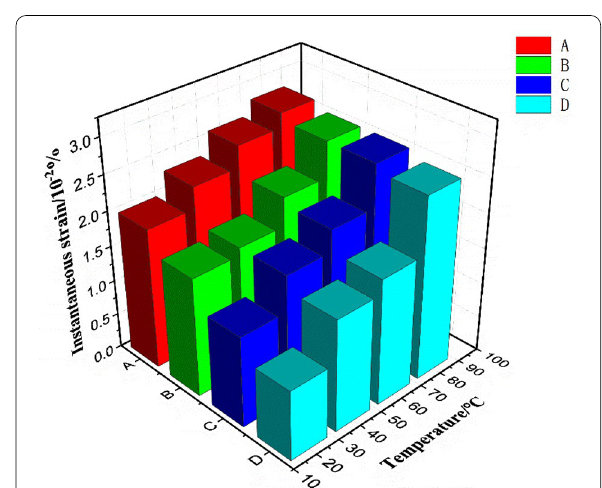
Fig. 5 Instantaneous strain of white oak specimens at different temperatures and distributions of earlywood vessel